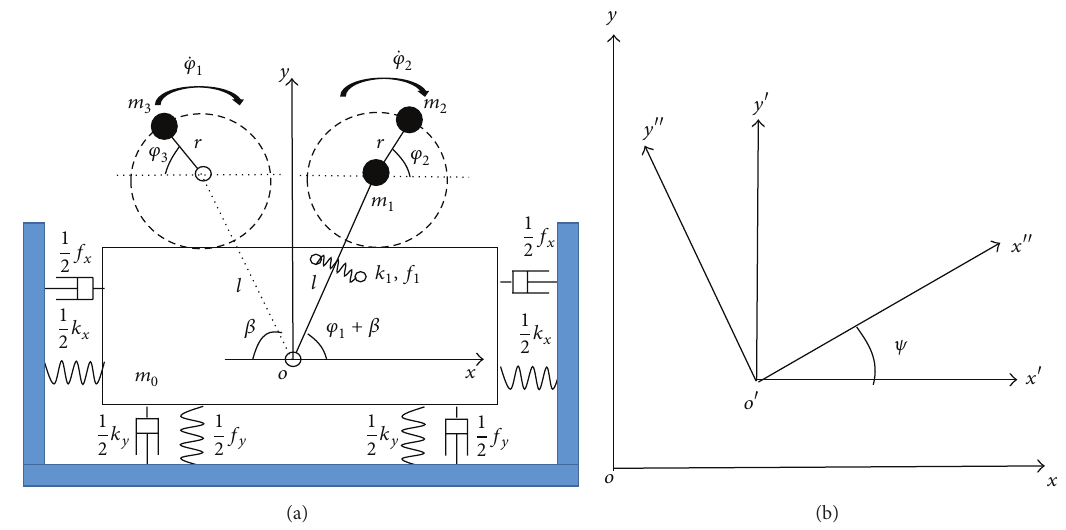
Figure 1: The model of the vibration system: (a) dynamic model of the double vibrobody system with two induction motors rotating in the same direction and (b) the reference frame